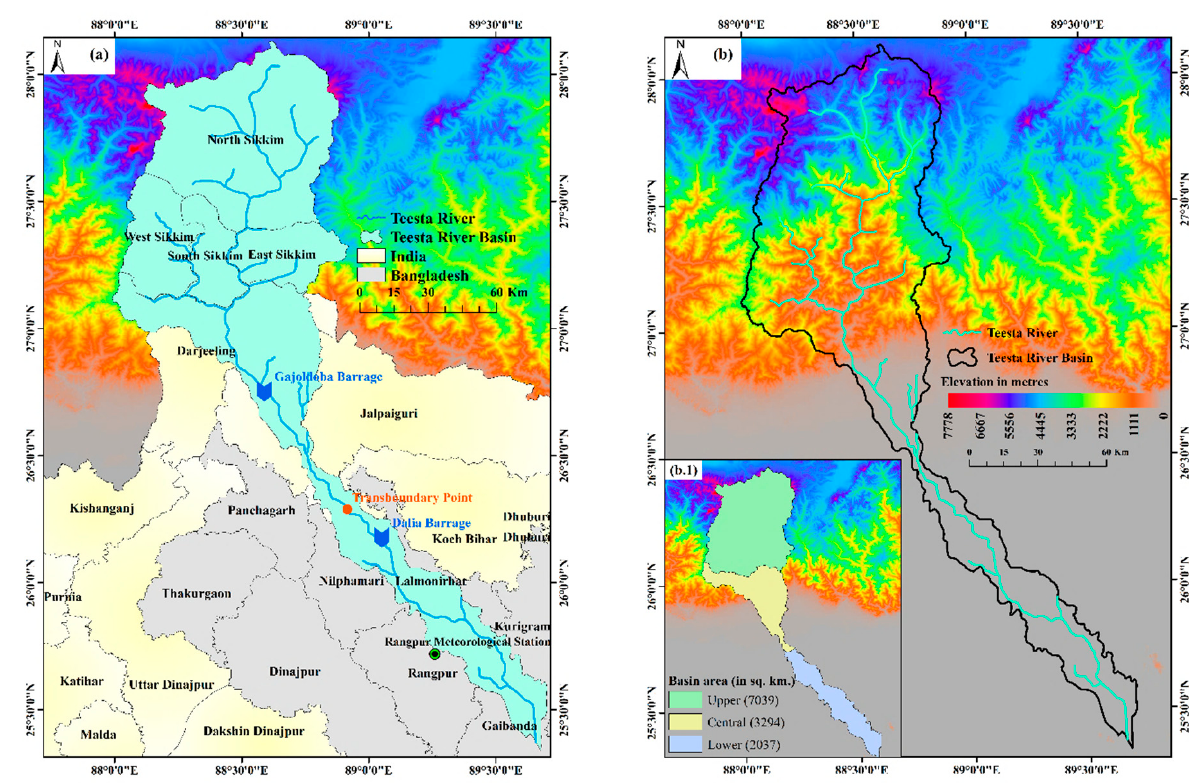
Figure 1. Map showing ( a ) geographical location of the Teesta river basin along with the administrative divisions, ( b ) elevation, and ( b.1 ) area covered by the river basin.